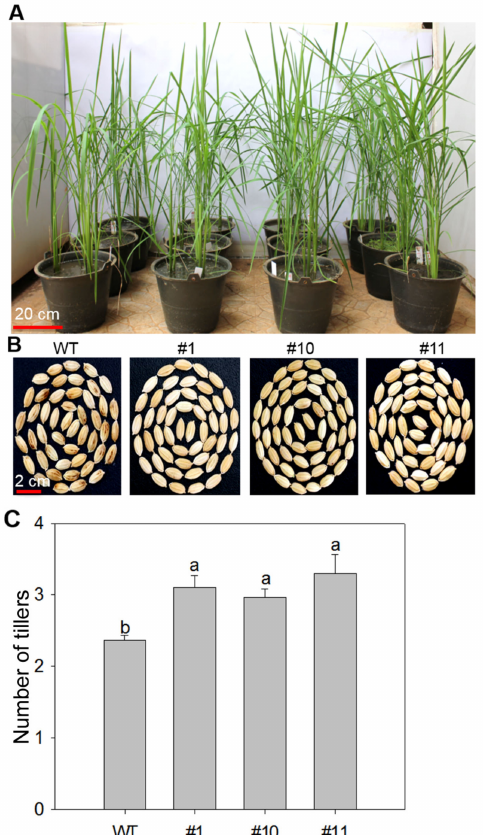
Figure 2. Agronomic traits of wild-type (WT) and three MoSDT1 overexpressing lines. ( A ) The picture showing the growth of WT and three MoSDT1 transgenic lines. Bar = 20 cm. ( B , C ) Kernel morphology ( B ) and the number of tillers ( C ) of WT and three MoSDT1 transgenic lines. Bar = 1 cm. Di ff erent letters represent statistically significant di ff erences ( p <